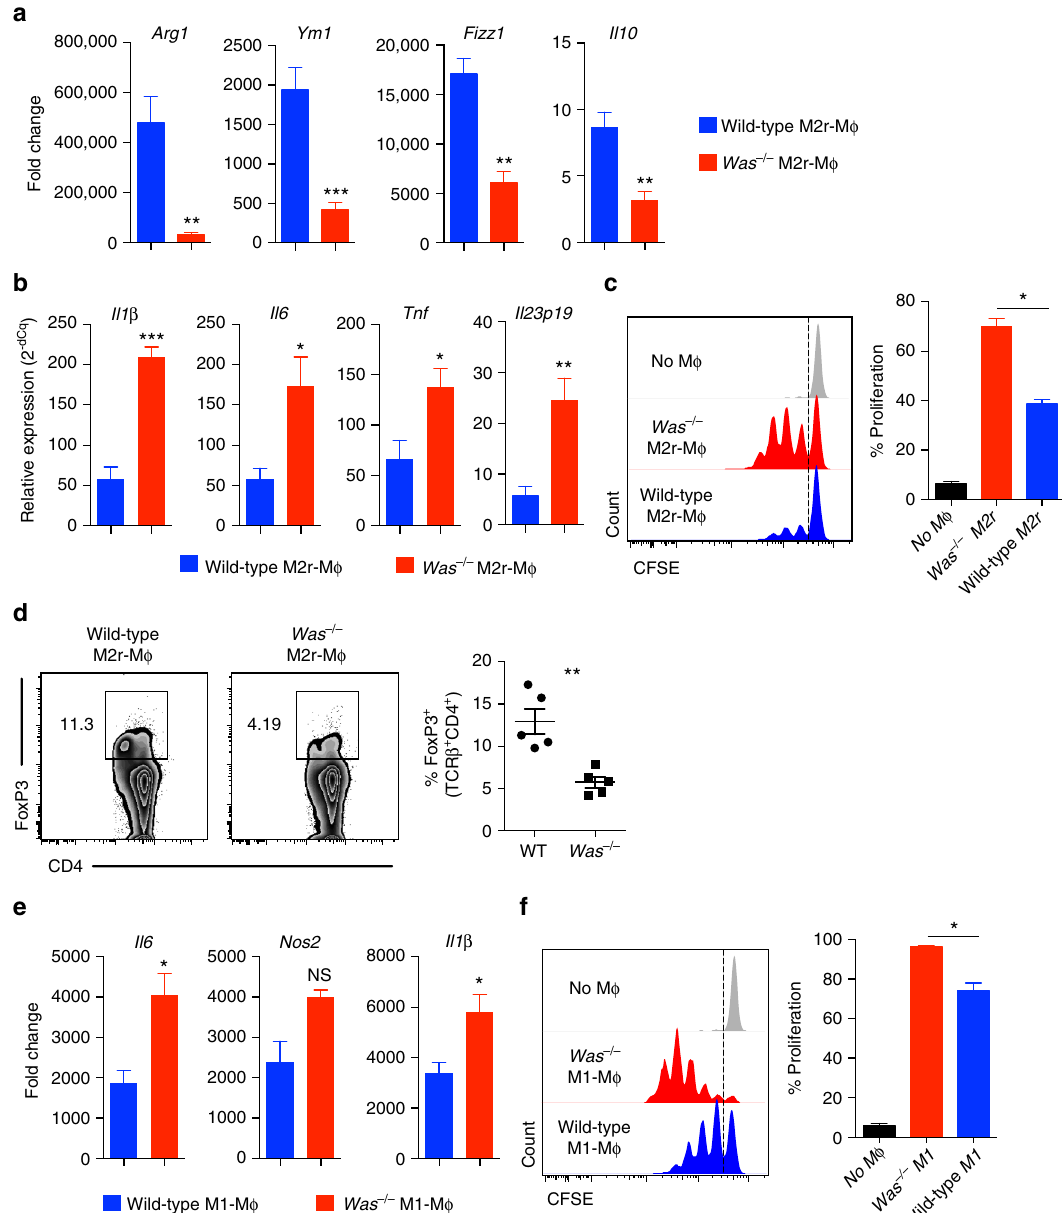
Fig. 4 Defective in vitro differentiation and function of M2r and M1 macrophage in absence of WASP. BMDM from WT and Was − / − mice were cultured in presence of IL-4, IL-10 and TGF- β to differentiate them into M2r macrophages. a qPCR analysis of M2 speci fi c gens expression (WT n = 5; Was − / − n = 5). Data are representative of three independent experiments. b qPCR analysis of proin fl ammatory gene expression in WT ( n = 5) and Was − / − ( n = 5) M2r- macrophage after restimulation with LPS for 4 h. Data are representative of three independent experiments. c CFSE (carboxy fl uorescein succinimidyl ester)-labelled naive CD4 + CD25 − T cells were cultured in presence of plate bound anti-CD3 (2 μ g/ml) and either WT or Was − / − M2r macrophages for four days. T-cell proliferation was determined by fl ow cytometer. Data are representative of three independent experiments. d Naive CD4 + CD25 − T cells were cultured in the presence of plate-bound anti-CD3 (2 μ g/ml), TGF- β (2 ng/ml) and either WT or Was − / − M2r macrophages for 5 days. FoxP3 expression were analysed by fl ow cytometry and quanti fi ed. Data are representative of three independent experiments. BMDM from WT and Was − / − mice were cultured in presence of LPS and INF γ to differentiate them into M1 macrophages. e qPCR analysis of M1 speci fi c gens expression (WT n =